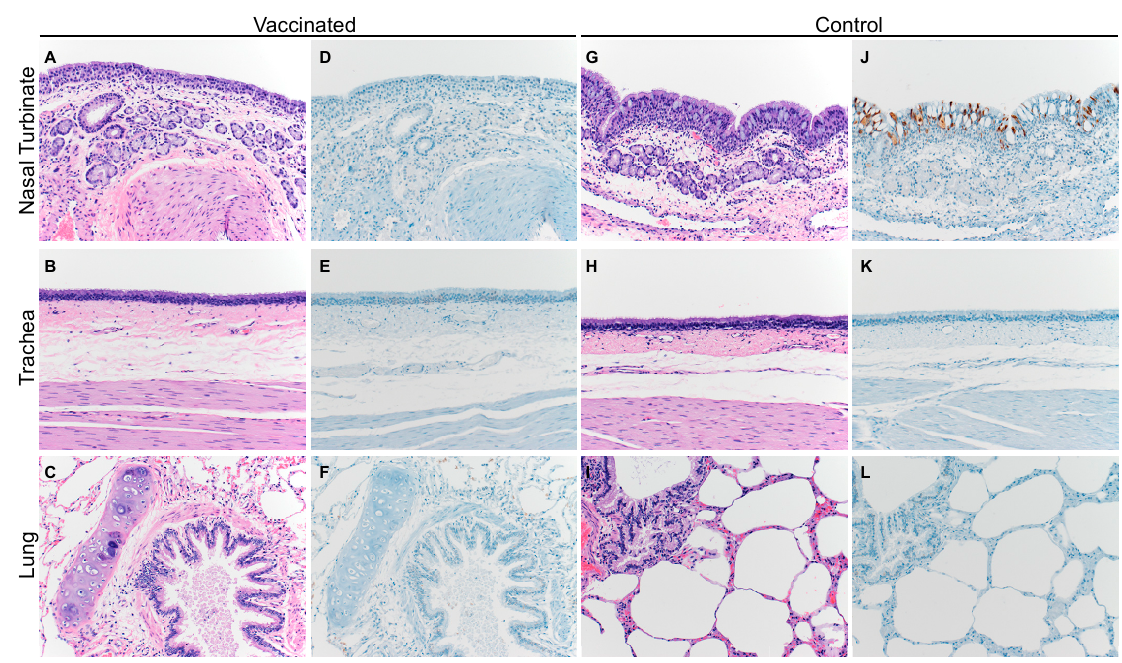
Figure 5. Histopathological changes in the respiratory tract of vaccinated and unvaccinated alpaca after challenge with MERS-CoV. Nasal turbinate, trachea, and lung were collected from vaccinated ( A – F ; A1 shown) and unvaccinated control animals ( G – L ; A3 shown) on 5 dpi and stained with hematoxylin and eosin ( A – C and G – I ), or a polyclonal anti-MERS-CoV antibody panels ( D – F and J – L ). MERS-CoV antigen is visible as a red brown staining in the immunohistochemistry panel. No histopathological changes were observed in the vaccinated alpaca whereas the unvaccinated control alpaca displayed multifocal, minimal-to-mild, acute rhinitis. MERS-CoV antigen was only detected in the nasal turbinates. Magnification: 400×.